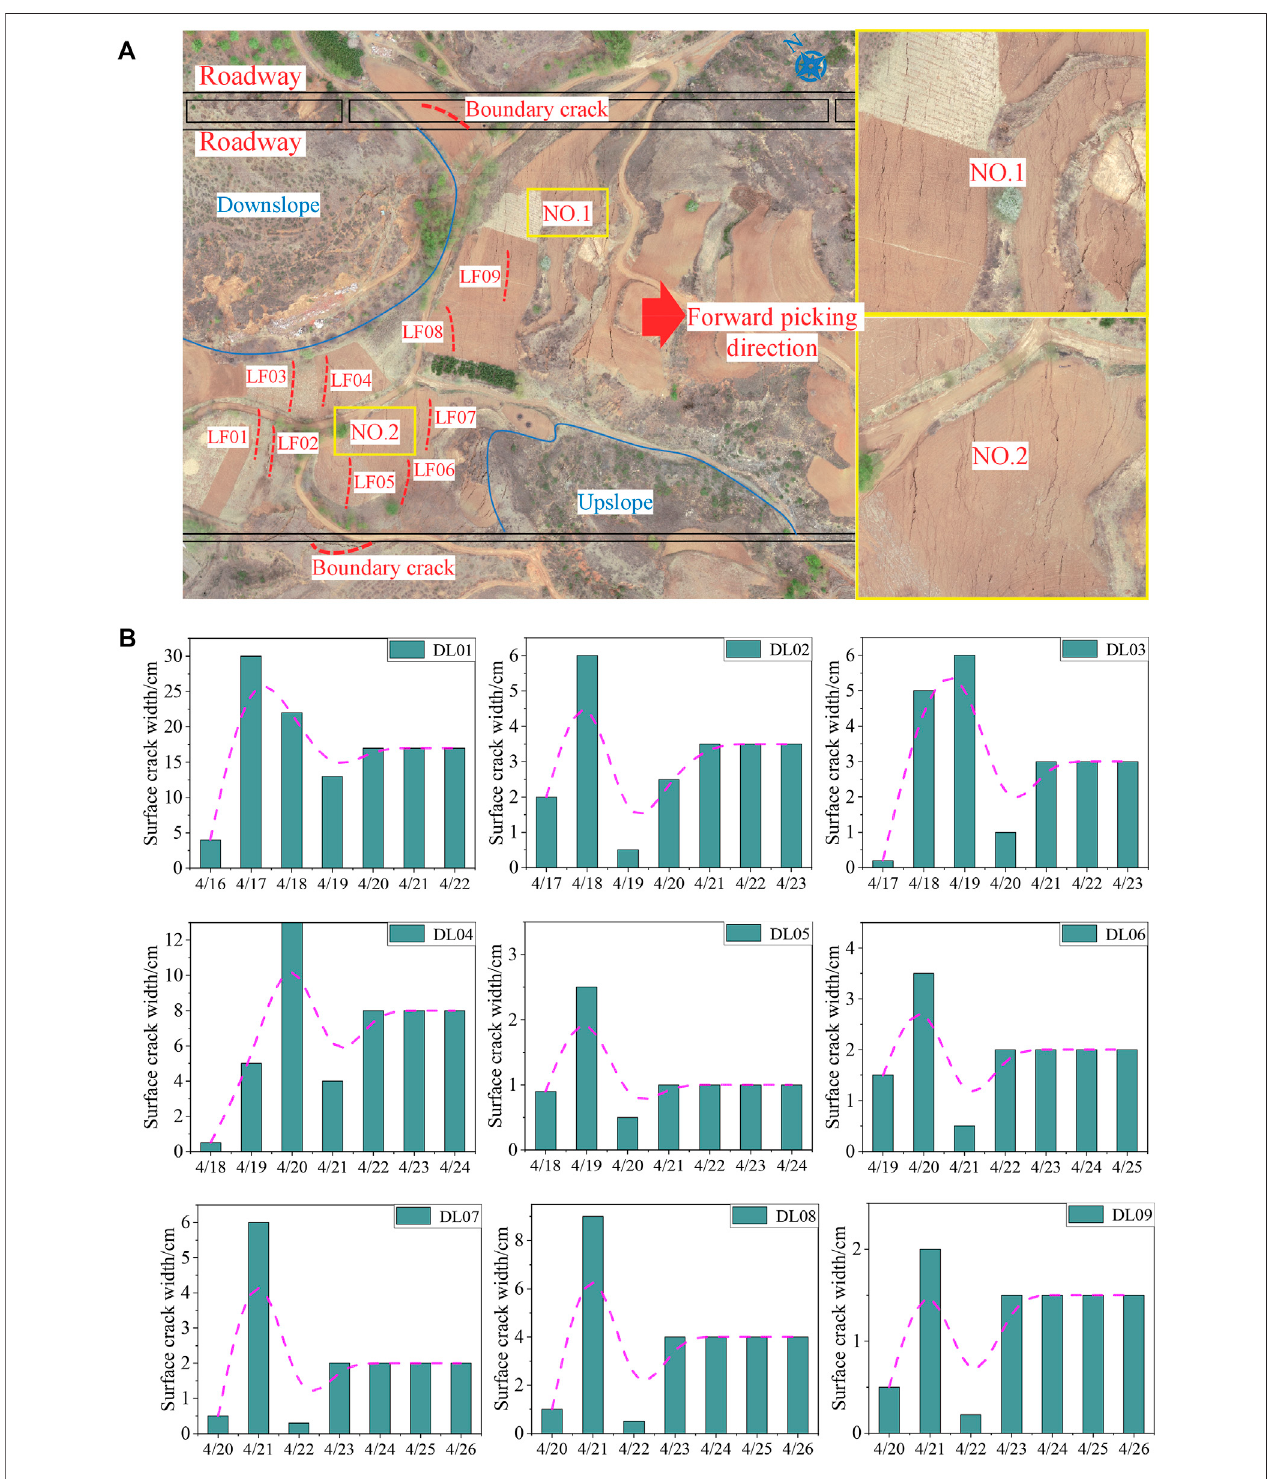
FIGURE 4 | Aerial photography and actual measurement of ground fi ssures on site: (A) Aerial photograph of ground fi ssures after retrieval; (B) Dynamic development characteristics of ground fi ssures in the gully.